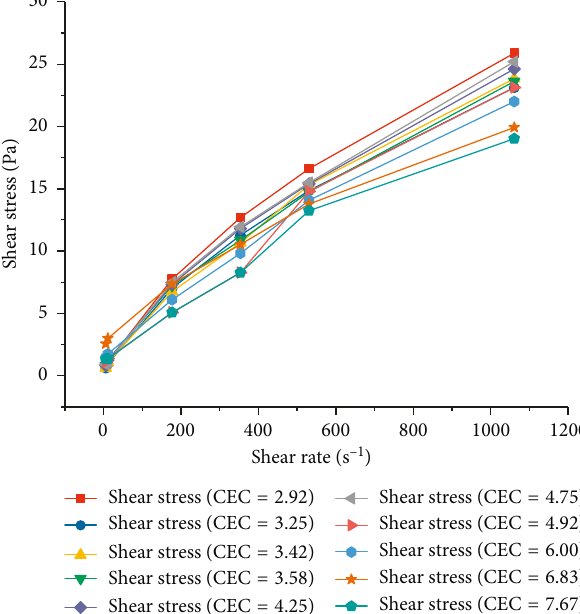
Figure 9: Rheological curves of slurry